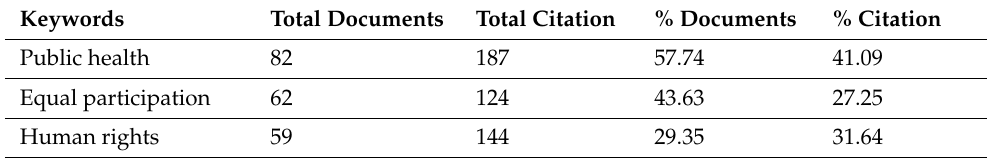
Table 5. Focus on Sustainable Development